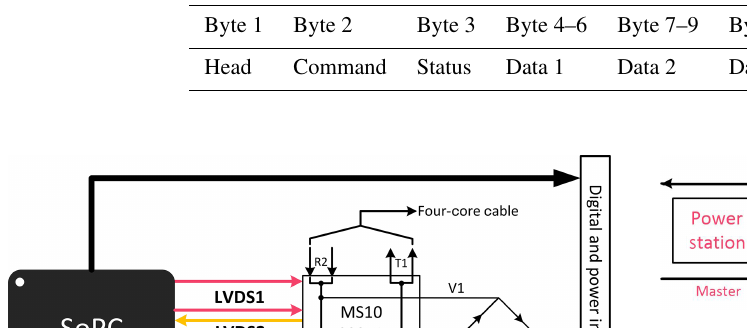
Figure 6. Schematic diagram of synchronous data acquisition and asynchronous communication of the data acquisition